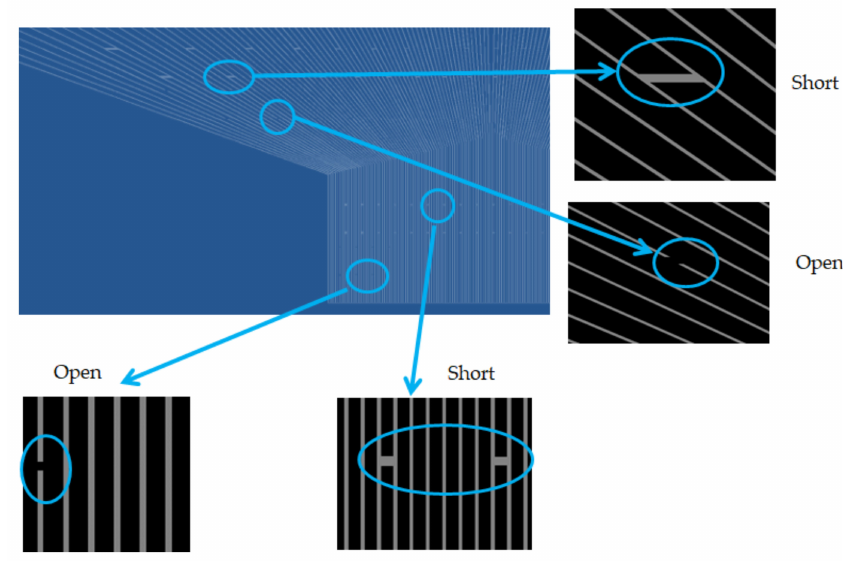
Figure 10. Verify at open and short defect on the right area of the photomask for